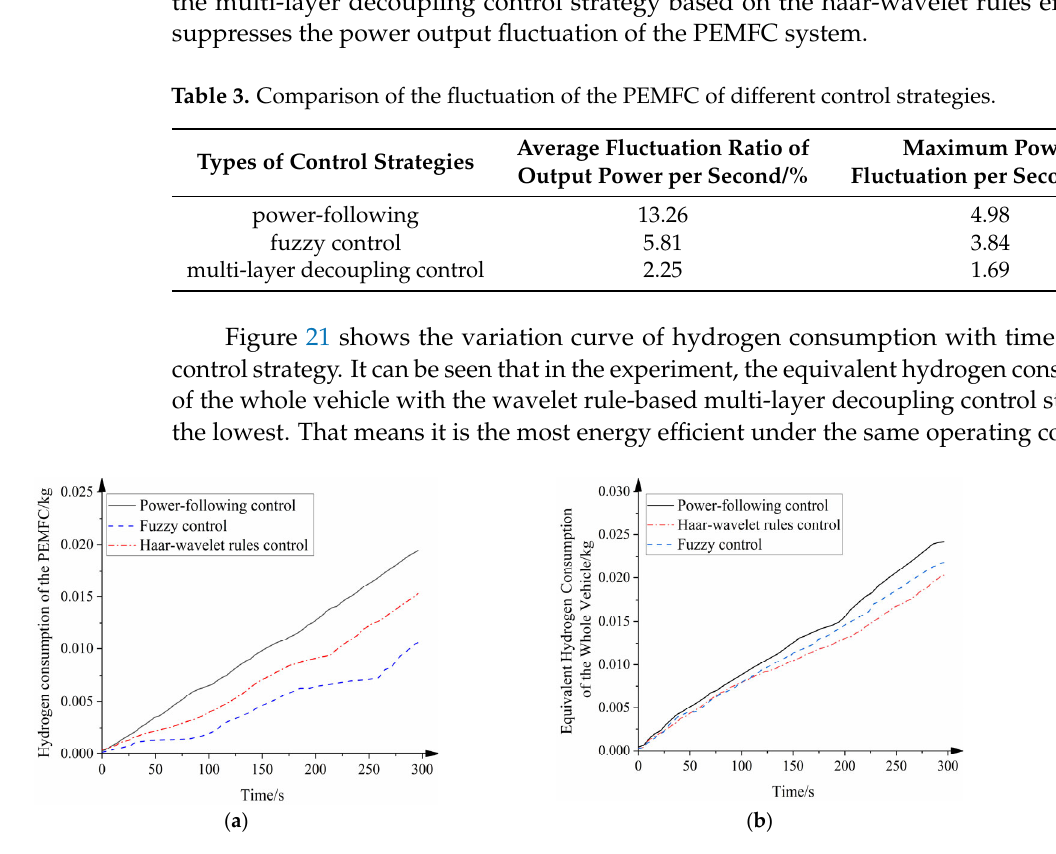
Table 3. Comparison of the fluctuation of the PEMFC of different control strategies.